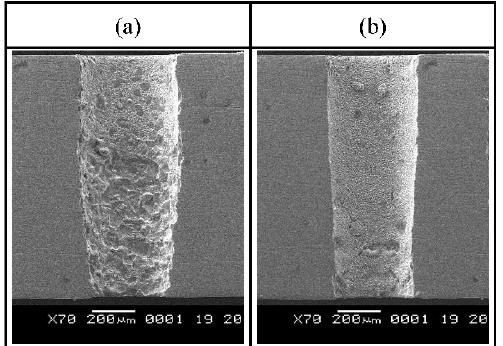
Figure 9. SEM image of micro hole profile under different duty factor; ( a ) 20%, ( b ) 40%.